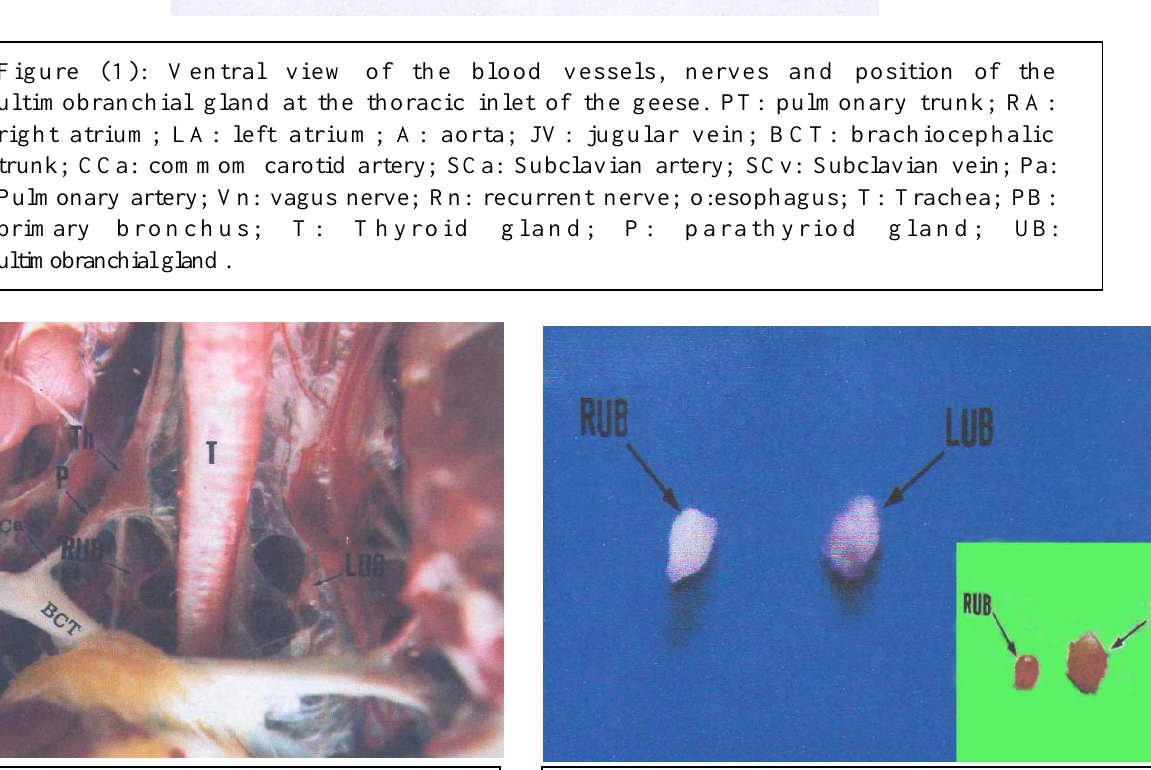
(Fig.3): Photogragh shows the position of ultimobranchial gland inadult geese, left ult i mobr anchi al ( LUB) ;r i ght ul t i mobr anchi al ;(RUB); Thyroid gland (TH); Parathyroid gland (P);Trachea (T); Brachiocephalic trunk (BCT); C om m on ca r ot i d ar t er y( C C a ) ; S u b cl a vi a n Artery